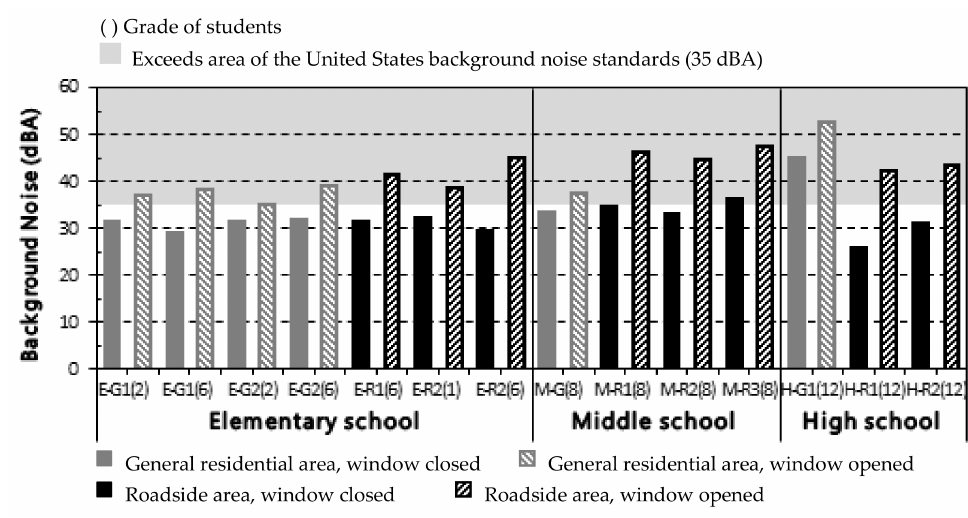
Figure 2. Measurement results of background noise levels in Korean classrooms (unoccupied). Figure 2 represents the background noise levels of the unoccupied classroom. The solid bars show the results when windows are closed, and the slashed bars show the results when windows are